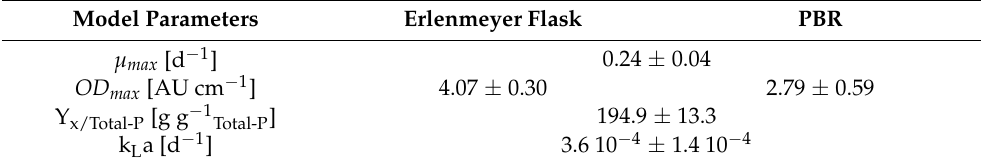
Table 2. Estimated kinetic parameters of the proposed model for P. kessleri cultivation in ADE. Model